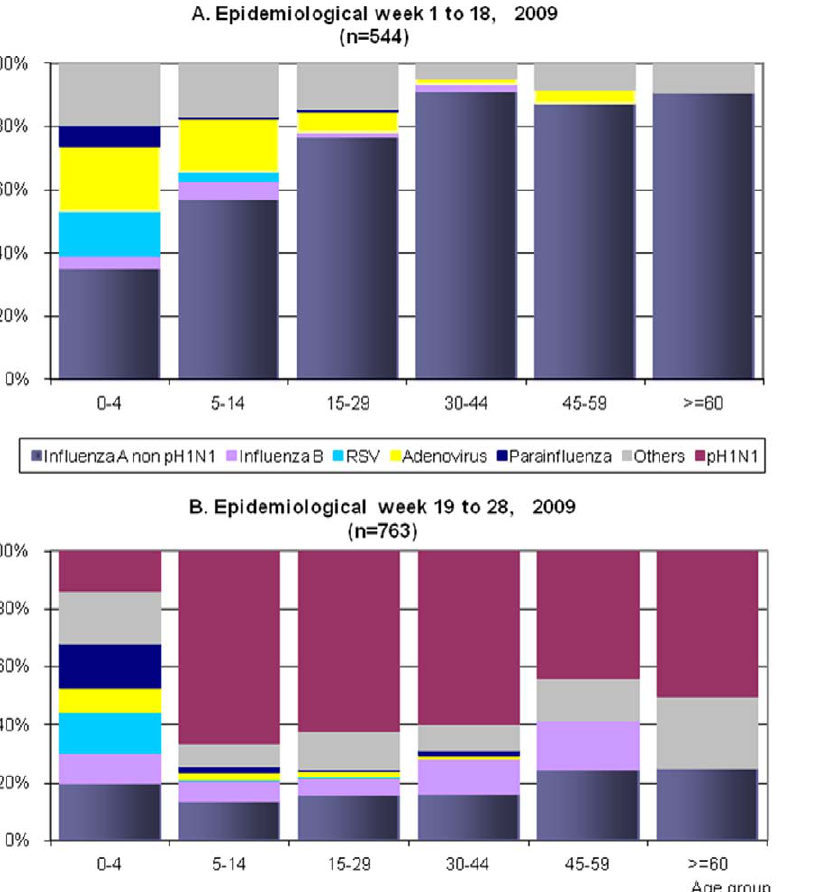
Figure 5. Distribution of viral etiology across age groups before and after the appearance of the novel pH1N1 virus in Peru, January 4 to July 13, 2009. A) Before the appearance of pH1N1 virus a total of 544 positive results were obtained from 505 positive patients (missing=3). B) After the appearance of the pH1N1 a total of 763 positive results were obtained from 730 positive patients (missing =4).